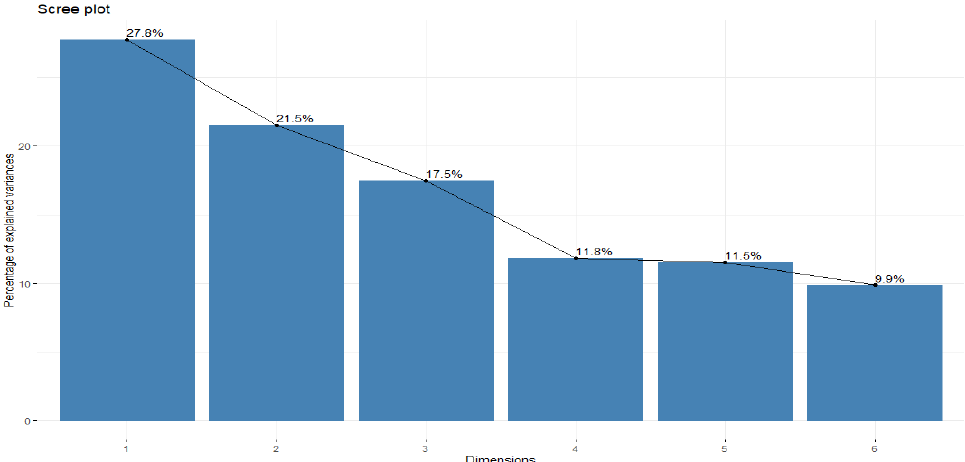
Figure 15. Eigenvalue diagram of the PCA associated with the climatology of the studied parameters.